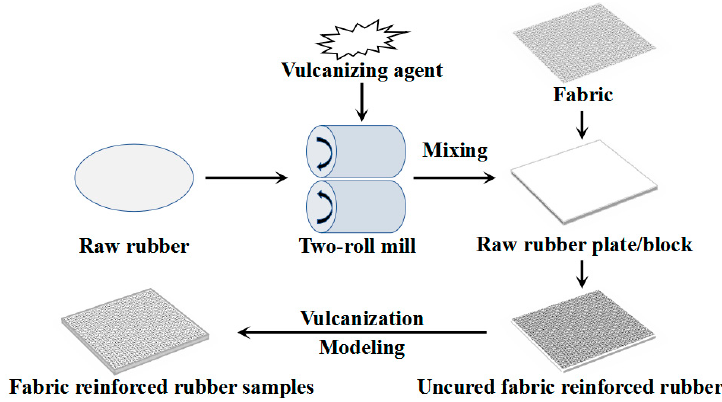
Figure 1. The preparation schematic diagram of fabric/rubber composites.